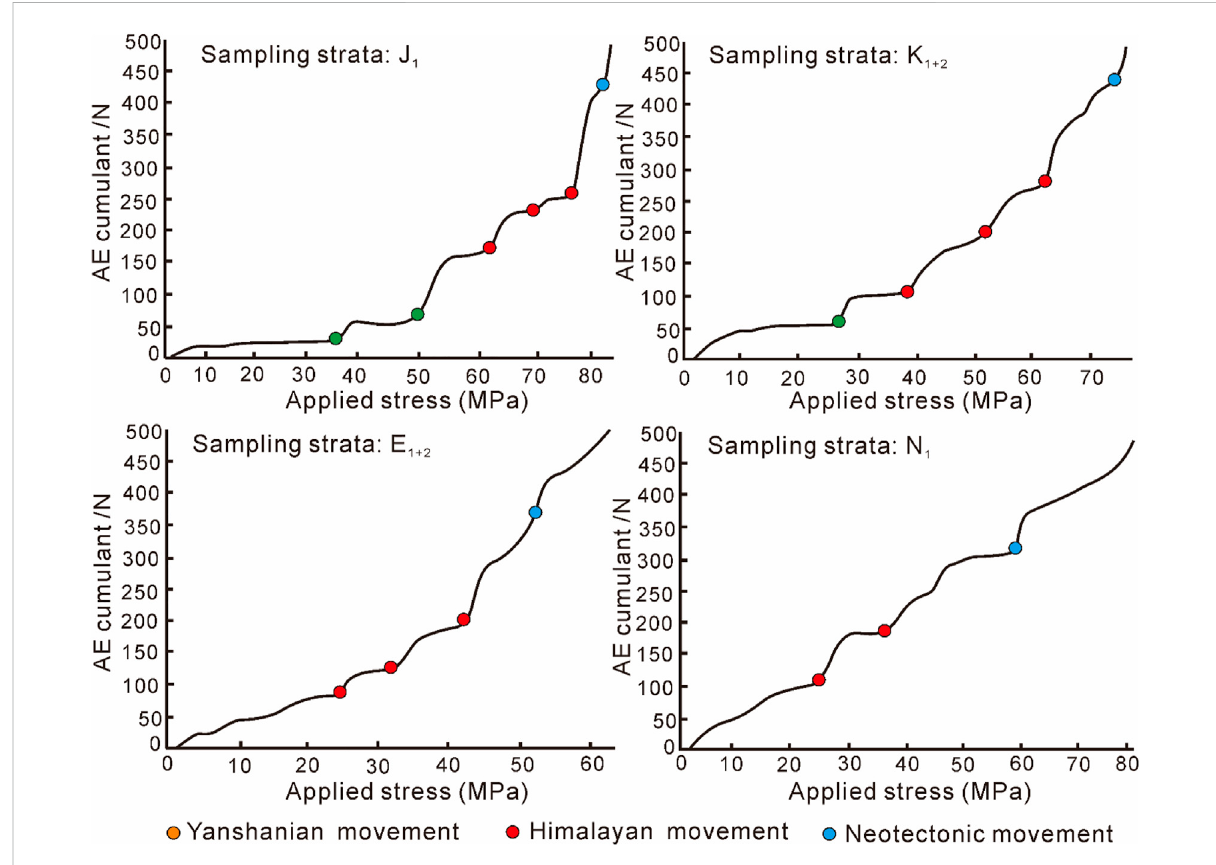
FIGURE 3 Typical response curves of AE experiment of rocks in different formations of Keshen gas reservoir (Note that this is only part of the